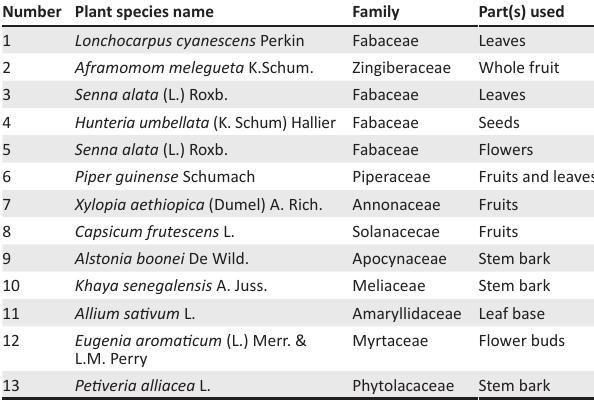
TABLE 12: Names of plants and their parts used for the formulation of traditional oral powdered herbal formulations for the treatment of piles in Ogbomoso,